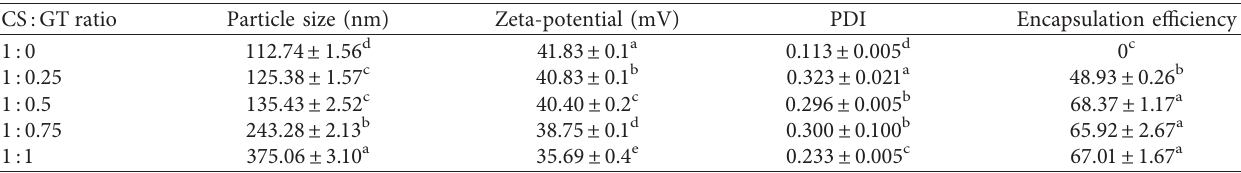
Table 1: Particle size, zeta potential, PDI, and encapsulation efficiency (EE) of CS-NP and CS-NP-GTprepared with different ratios of CS: GT.